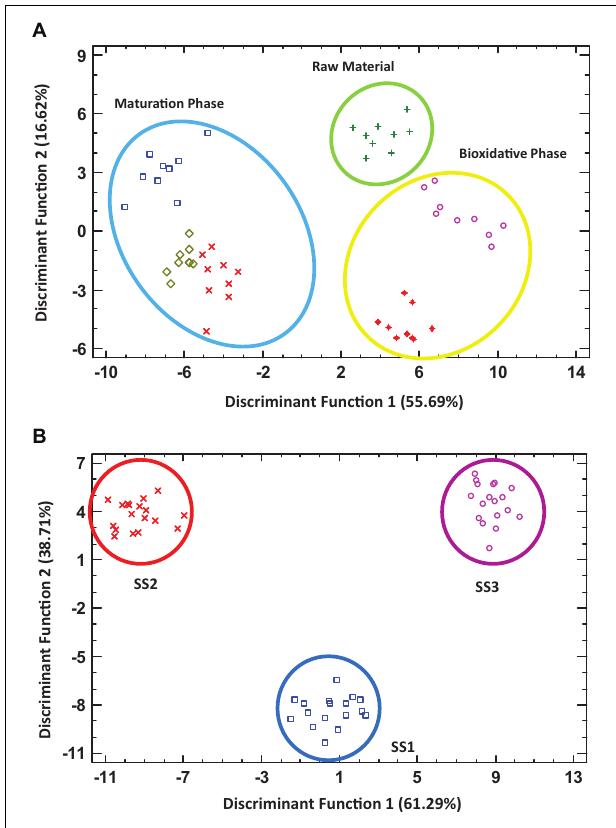
FIGURE 4 | Discriminant analysis based on composting of different sewage sludge processes, taking into account the monitoring parameters, biodiversity indices, and abundance of majority families. Panel (A) represents the data as a function of composting phases; Panel (B) represents the data as a function of the facilities